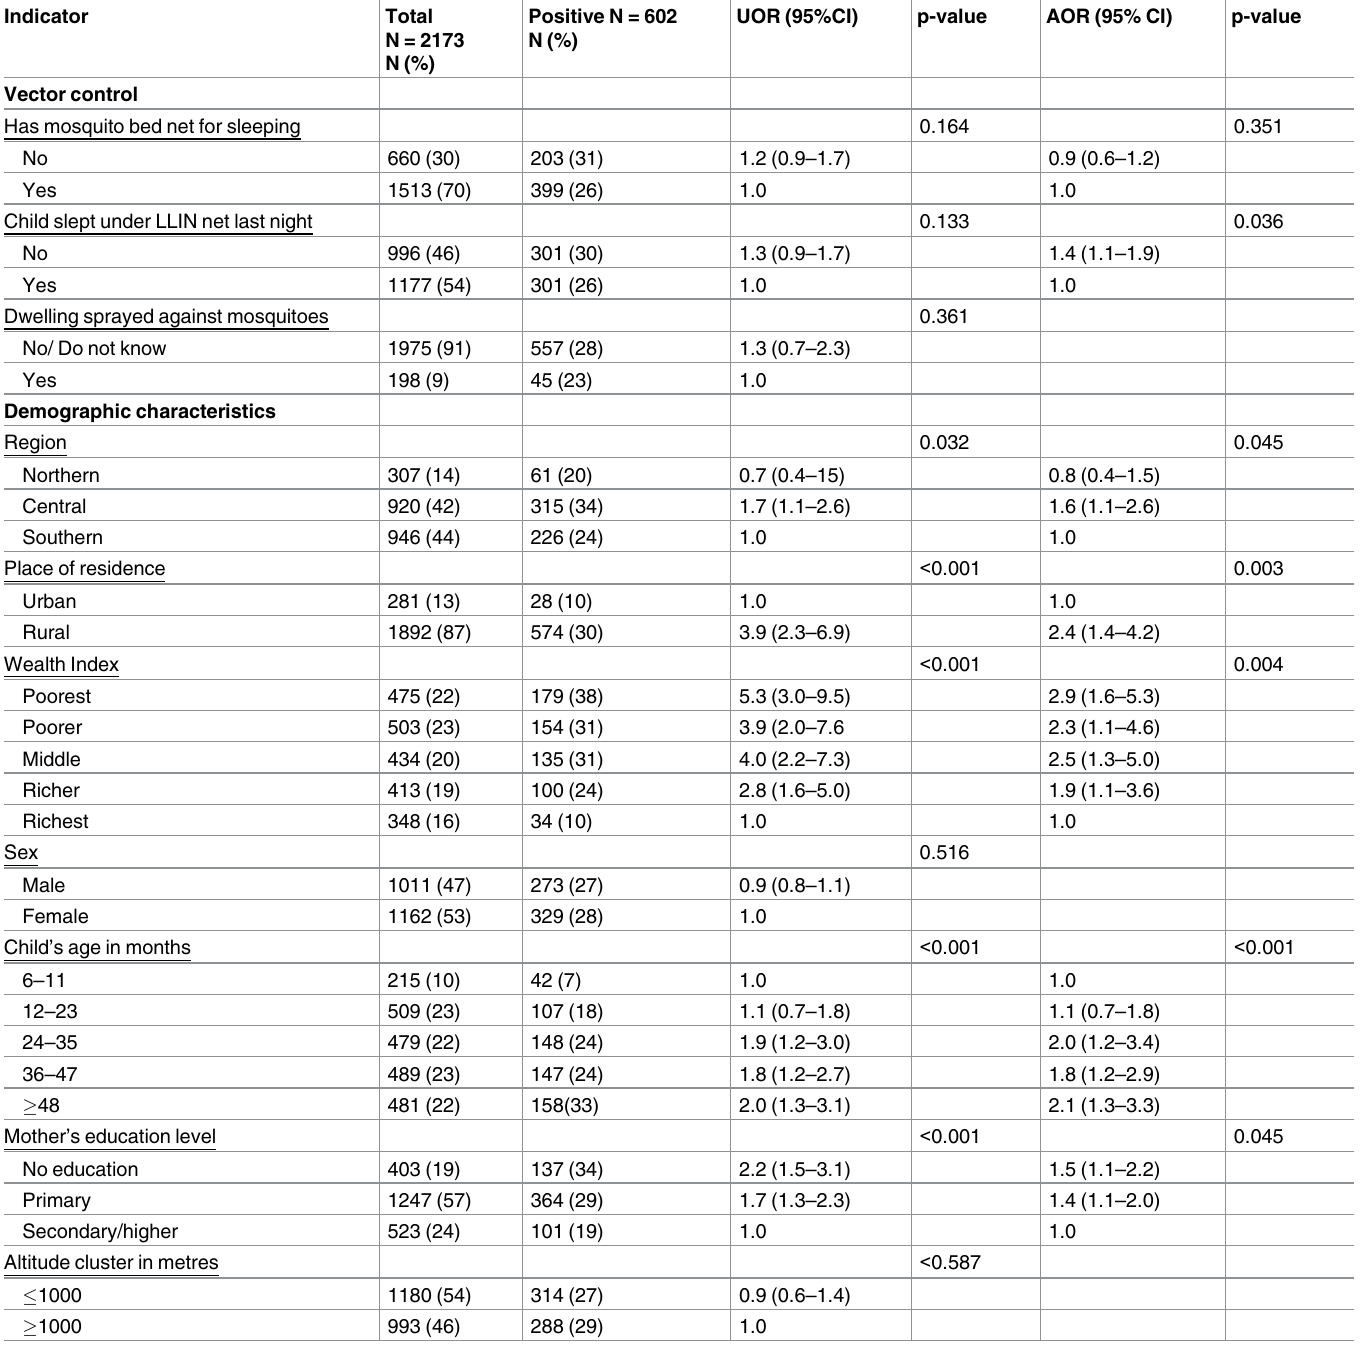
Table 2. Factors associated with malaria parasitaemia in 2012